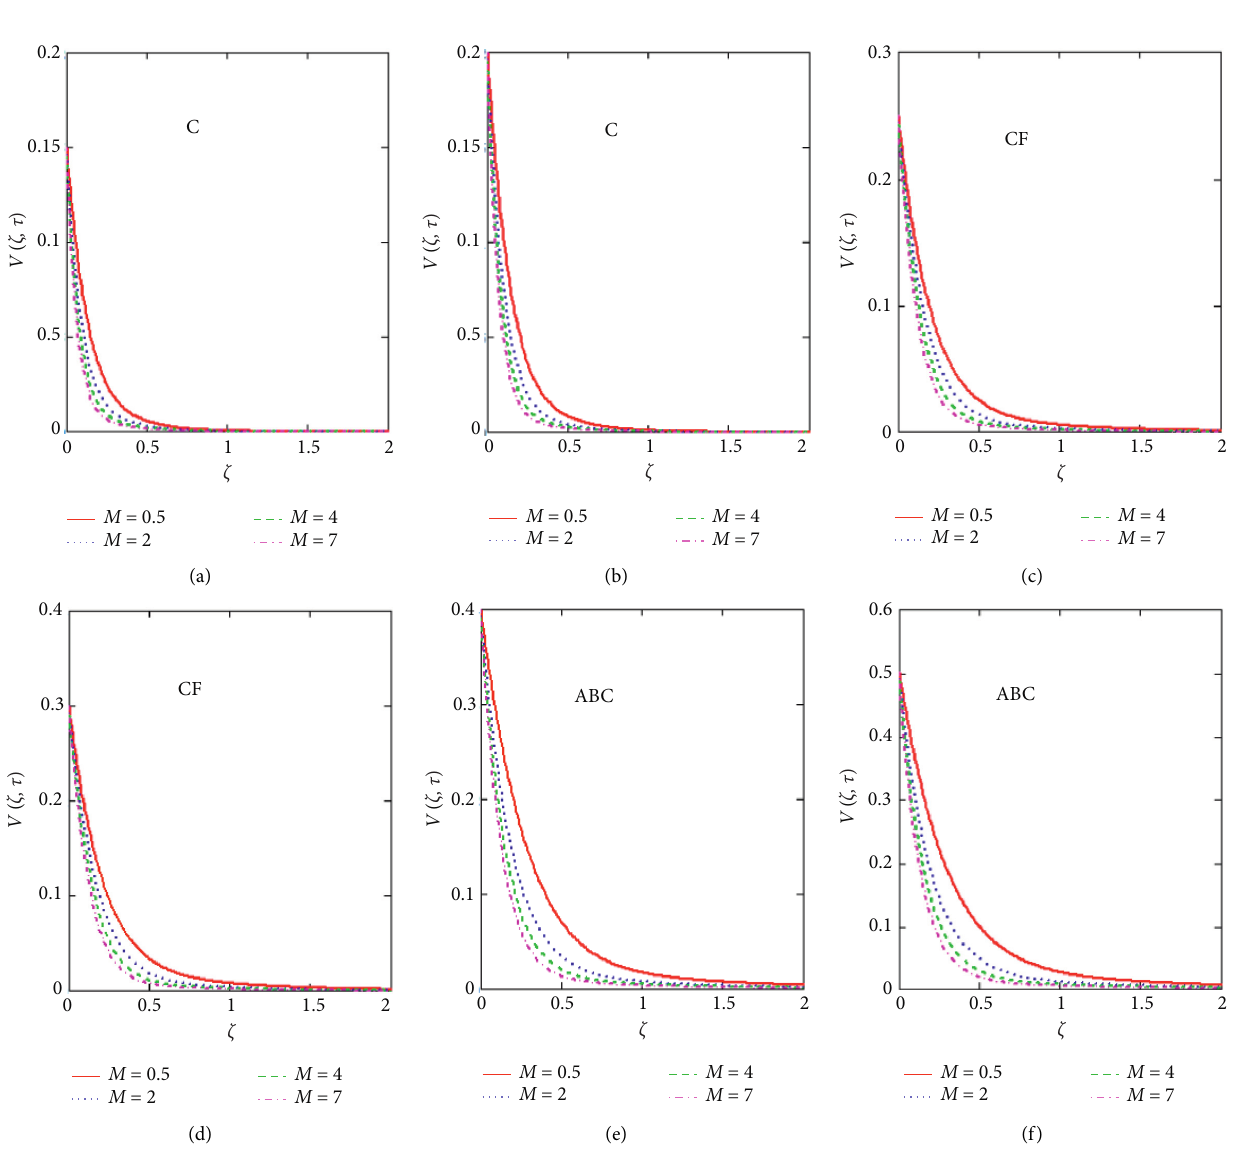
Figure 4: Plot via C, CF, and AB approaches for velocity with different values of M